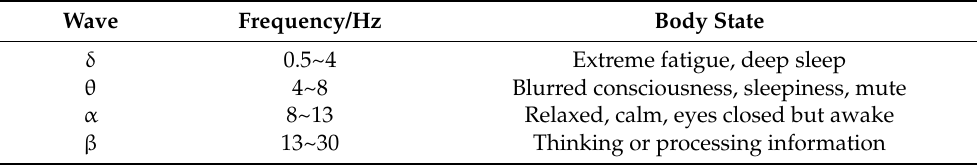
Table 4. EEG characteristics of different frequency fields.